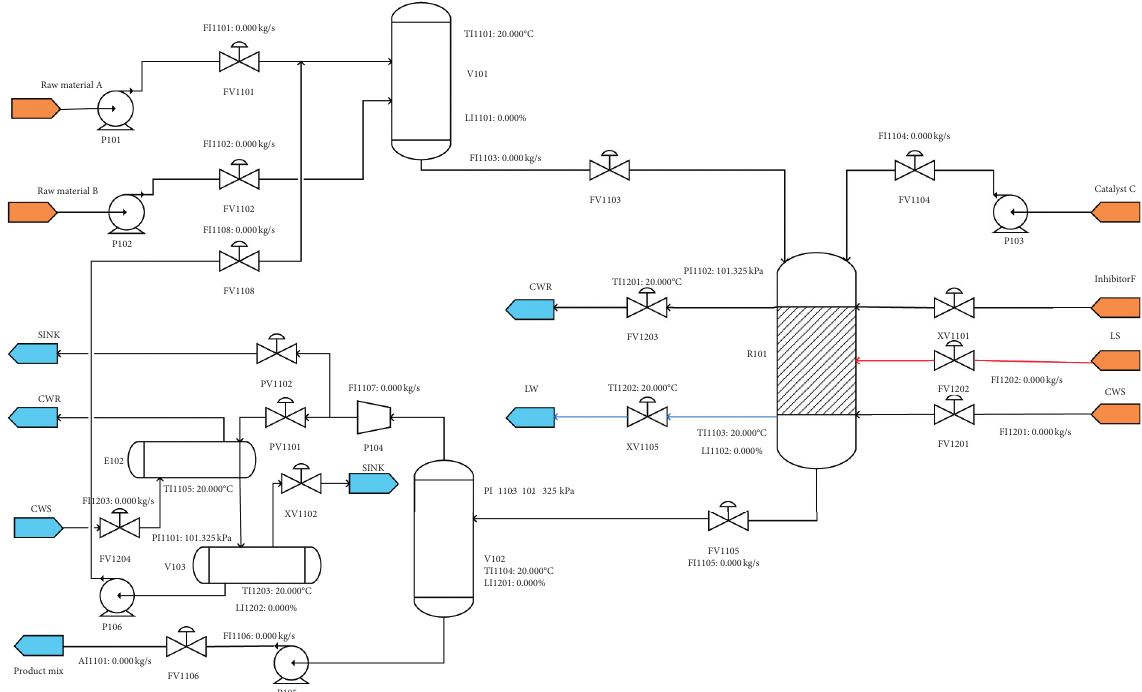
Figure 3: Continuous reaction process control system